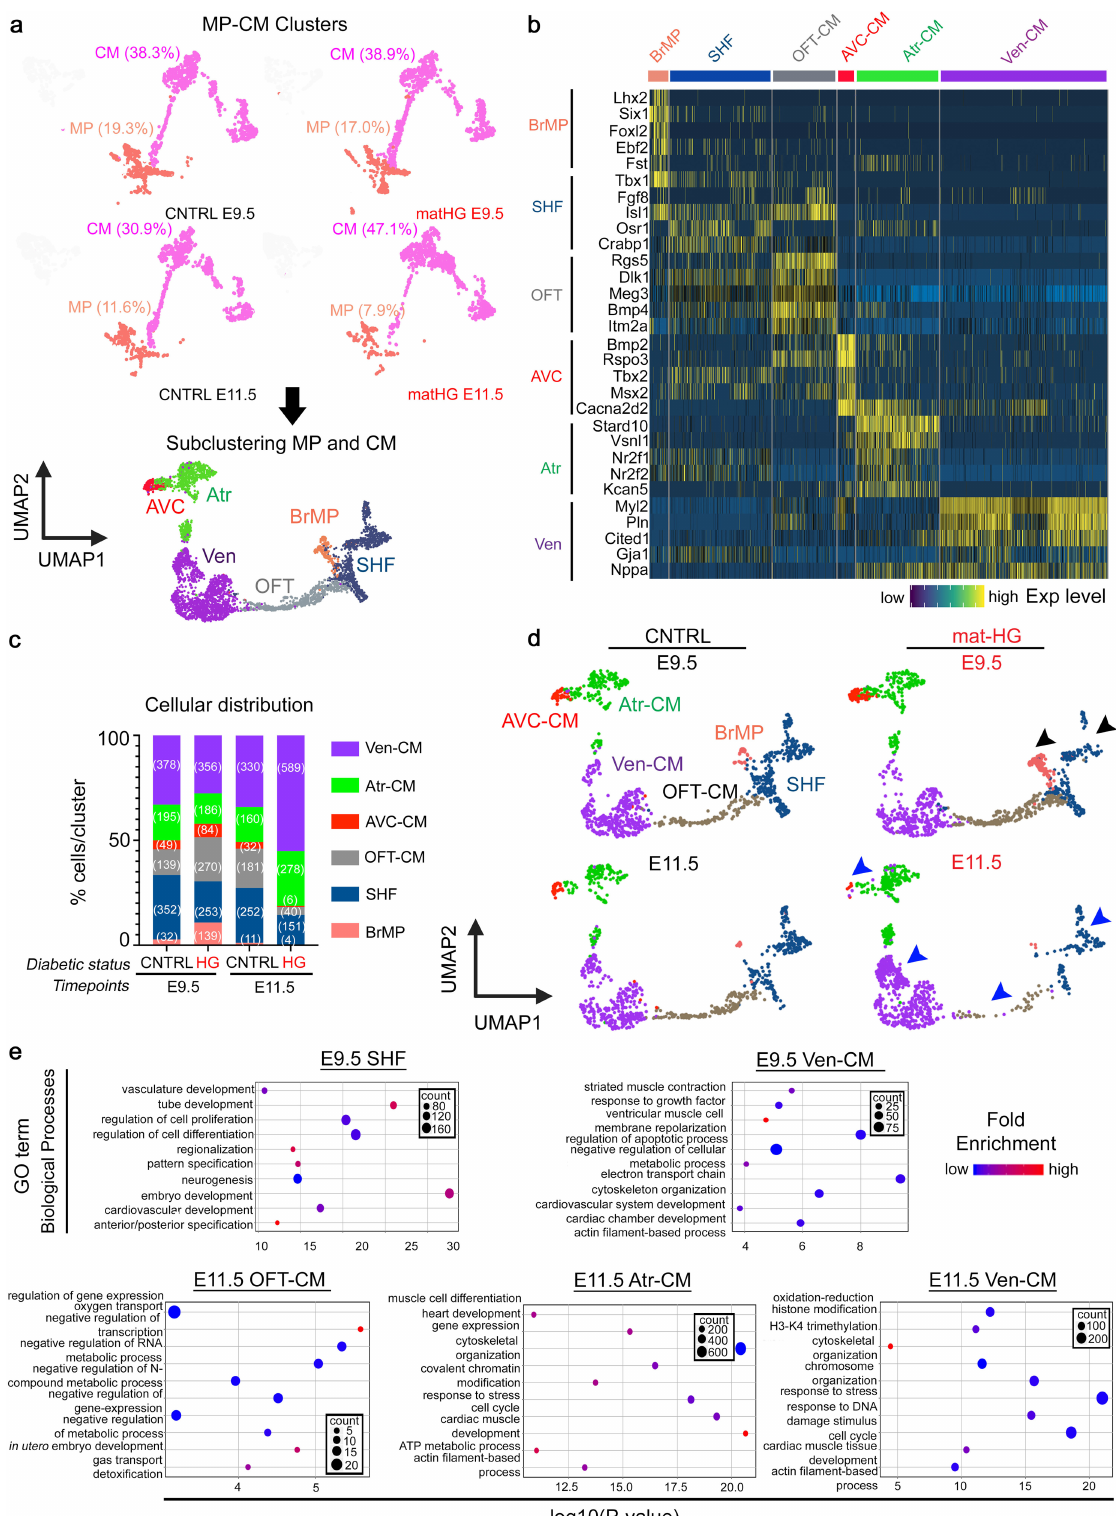
(ii) regulation of ion transport, (iii) cardiac muscle cell differentiation and proliferation, (iv) regulation of Wnt, Bmp, TGF and MAPK signaling pathways, (v) response to hypoxia, (vi) H3K4 trimethylation, and (vii) mitochondrial organization with the regulation of metabolic processes such as tricarboxylic acid cycle (Supplementary Fig. 8d, e and Supplementary Data 2,